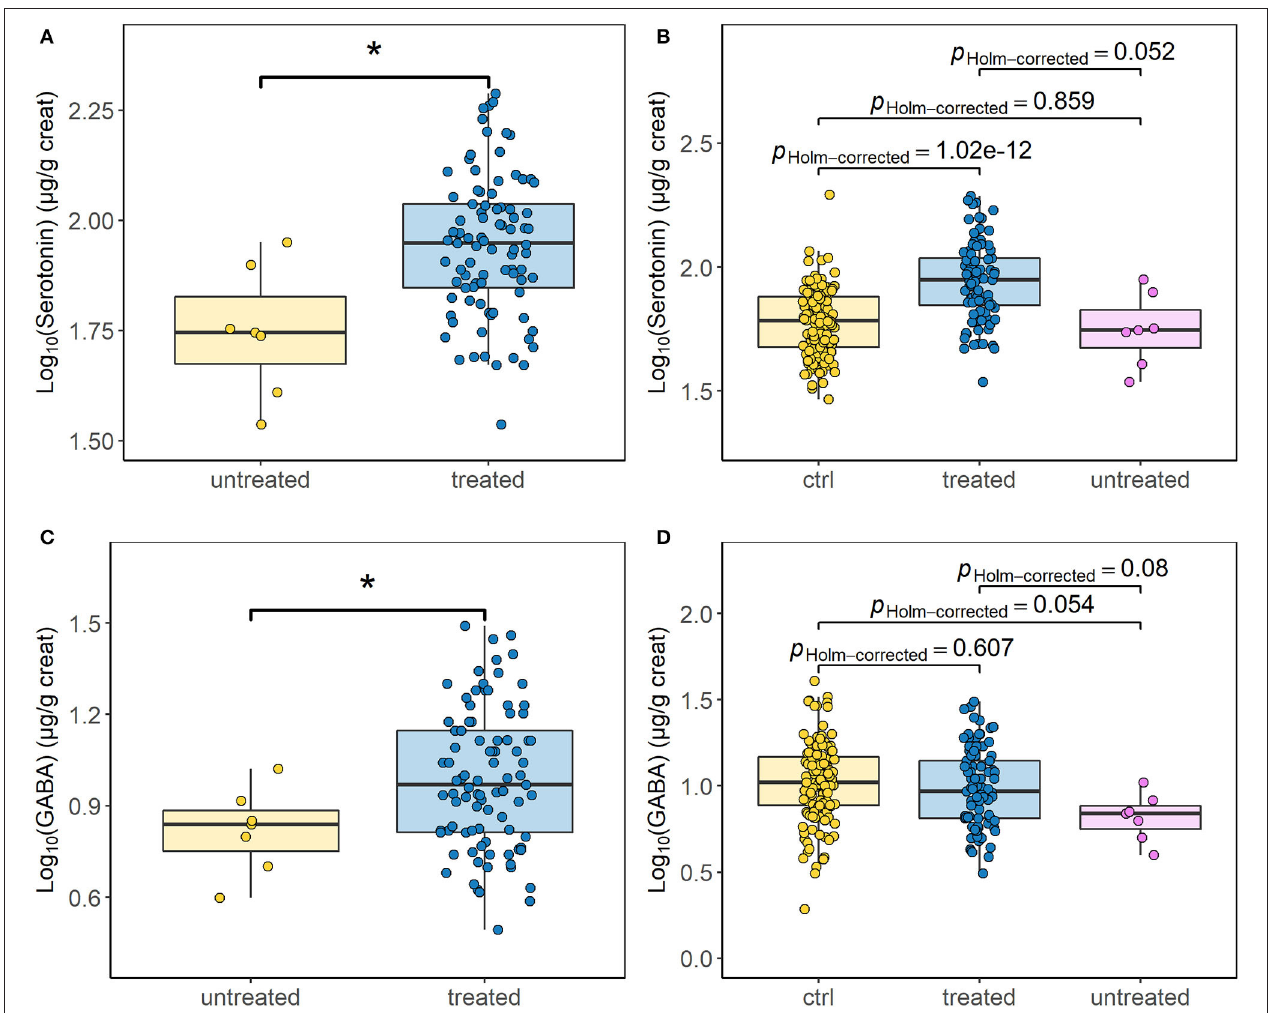
FIGURE 3 | Influence of the antiseizure drug treatment on the urinary neurotransmitter profile. (A) Urinary serotonin concentration compared between treated ( n = 56 dogs/89 samples) and untreated dogs ( n = 7 dogs/7 samples) affected by idiopathic epilepsy ( p ≤ 0.05). (B) Multiple group comparison of the urinary serotonin excretion between treated ( n = 56 dogs/89 samples) and untreated dogs ( n = 7 dogs/7 samples) with idiopathic epilepsy and the healthy control group (ctrl) ( n = 127 dogs/127 samples). (C) Urinary È -aminobutyric acid (GABA) concentration compared between treated ( n = 56 dogs/89 samples) and untreated dogs ( n = 7 dogs/7 samples) with idiopathic epilepsy ( p ≤ 0.05). (D) Multiple comparisons of the urinary È -aminobutyric acid excretion between treated ( n = 56 dogs/89 samples) and untreated dogs ( n = 7 dogs/7 samples) with idiopathic epilepsy and the healthy control group ( n = 127 dogs/127 samples). Data are presented as box-and-whisker plots (the median is represented by the central line, the 25th and the 75th percentile represent the lower and upper limit, and the length of the whiskers represent the 1.5 multiple of the interquartile range). Unpaired two-sided two-sample t -test and Wilcoxon–Mann–Whitney test were used for group comparison. For multiple group comparisons a one-way analysis of variance (ANOVA) and a Games-Howell post-hoc test with the Holm correction was utilised. * p ≤